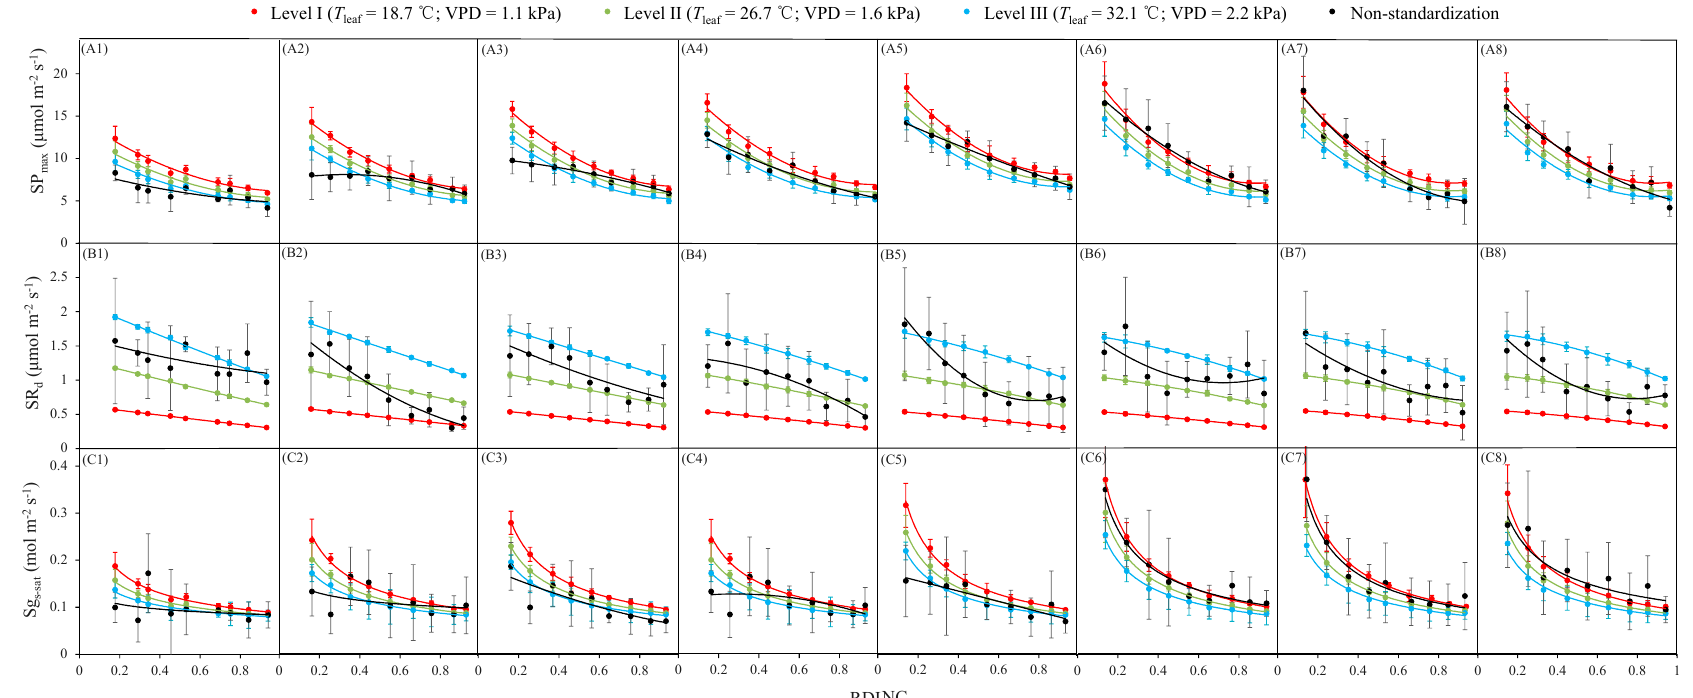
Figure 5. Vertical profiles of the standardized and nonstandardized light-saturated net photosynthetic rate (SP max ) ( A ), dark respiration (SR d ) ( B ) and light-saturated stomatal conductance (Sg s-sat ) ( C ) during the growing season. (1–8) represent eight measurement campaigns from 15th May to 10th September, respectively. Data points represent the mean values (solid bars represent the standard deviation) in each RDINC (relative depth into the crown) and measurement period. Solid lines are trend lines.